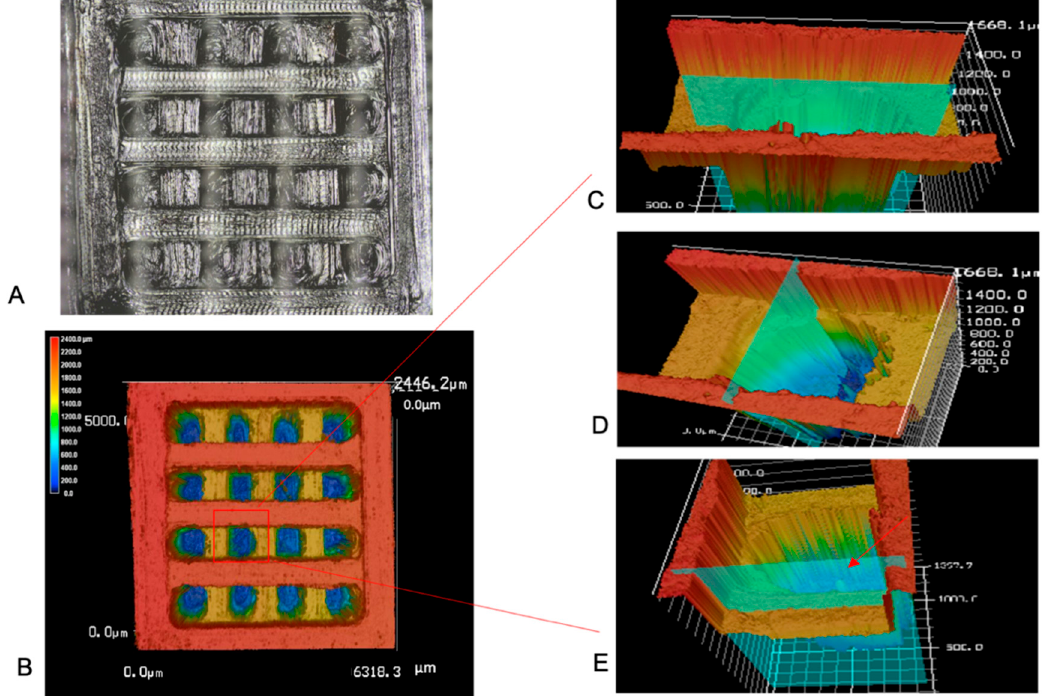
Figure 5. ( A ). Optical and laser combined picture of 3D printed square. ( B ). Laser confocal image of 3D printed square. ( C ). Horizontal section of selected pore, the horizontal distance was measured (584.16 ± 95.28 μ m, n = 60). ( D ). Vertical section of selected pore, the vertical distance was measured (620.39 ± 93.03 μ m, n = 60). ( E ). Vertical section of selected pore, the layer thickness was measured (423.15 ± 82.7 μ m, n = 60).